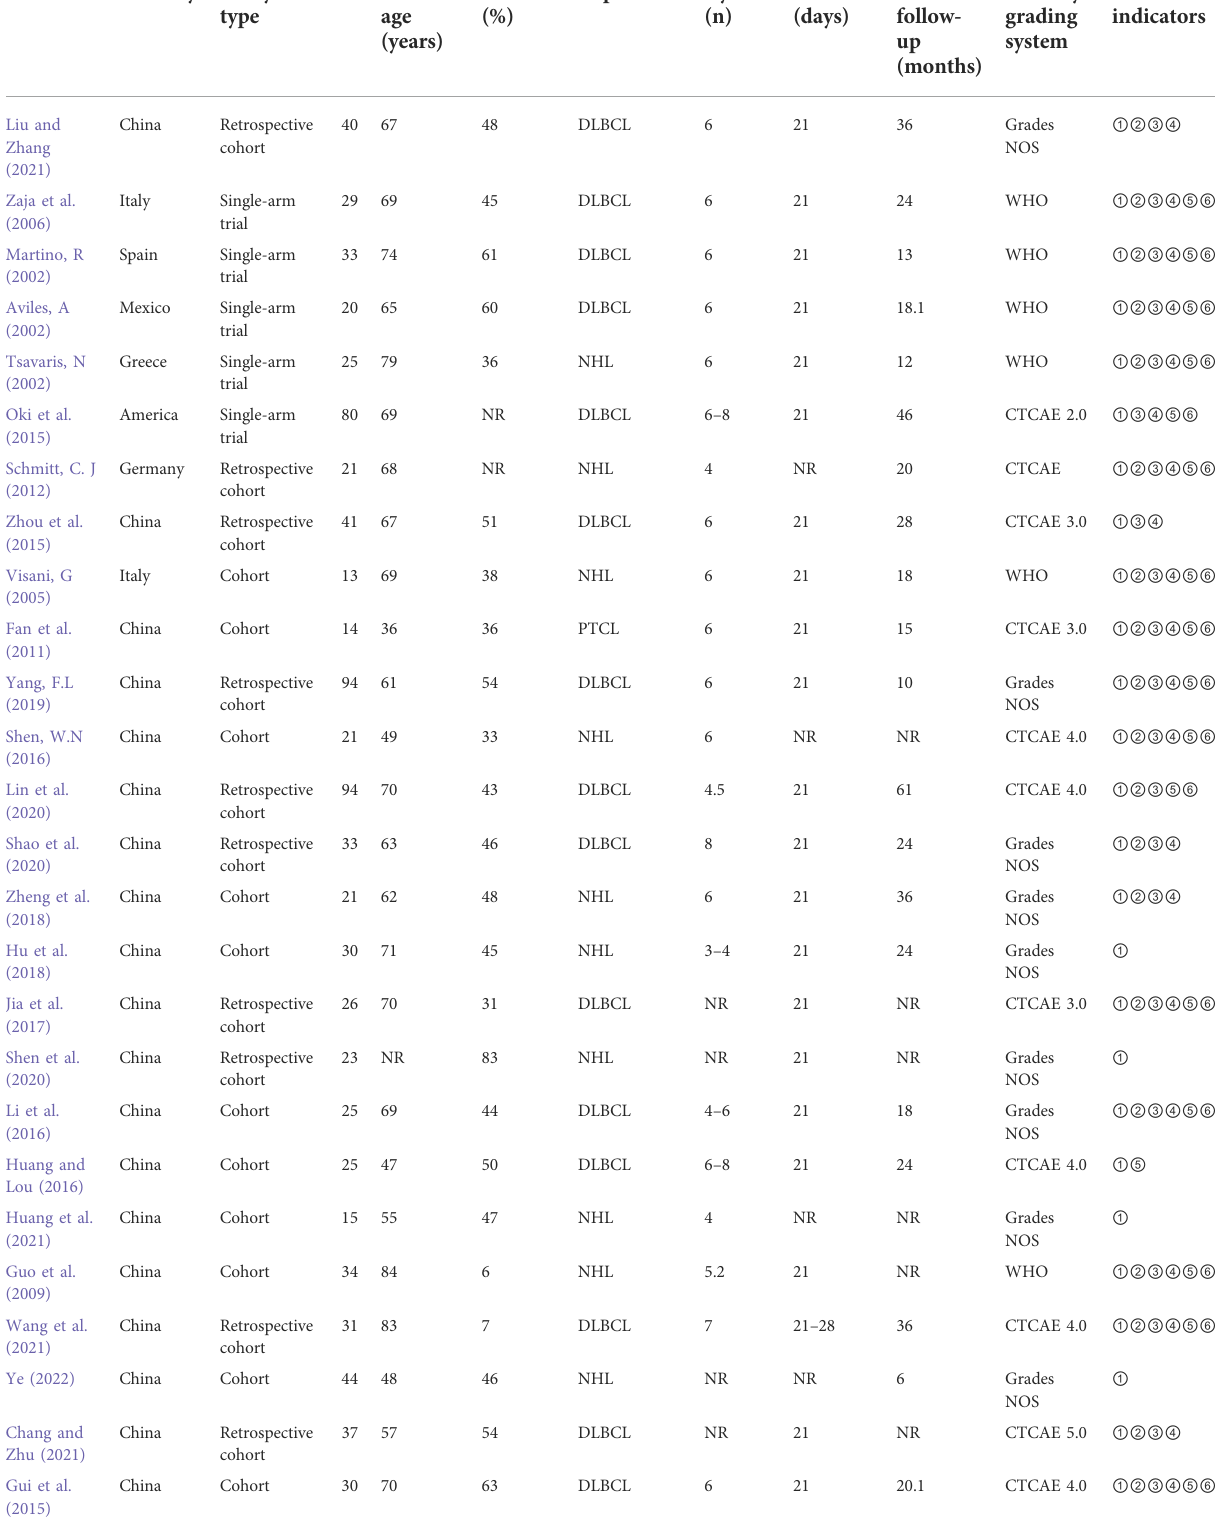
TABLE 1 Baseline characteristics of single-arm studies